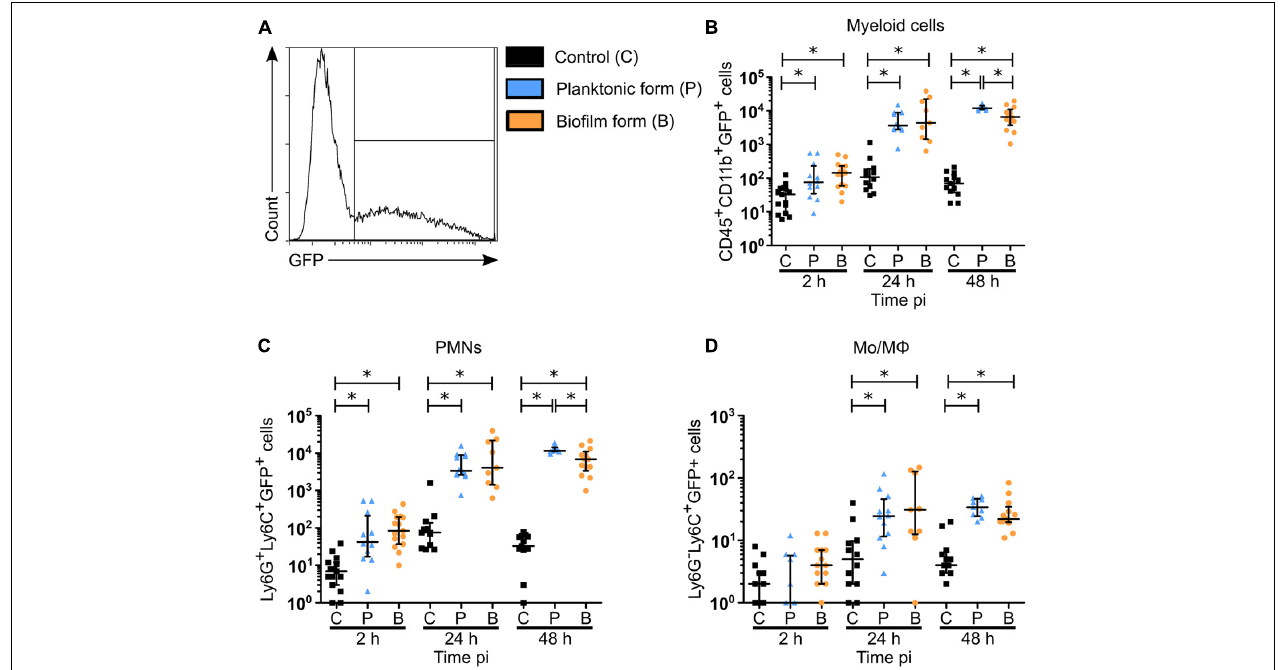
FIGURE 6 | Biofilm bacteria associated myeloid cells in the skin of S. aureus infected mice. (A) Flow cytometric analysis showing the gating strategy to analyze GFP-SH1000 associated cells among myeloid cells (CD45 + CD11b + GFP + ), PMNs (Ly6G + Ly6C + GFP + ), and MOs/M (cid:56) s (Ly6G - Ly6C hi GFP + ). Representative histogram is shown from planktonic infected WT C57BL/6J mice at 48 h pi. (B–D) Total number of bacteria associated myeloid cells (B) , PMNs (C) , and MOs/M (cid:56) s (D) in ear pinna tissue of control and planktonic or biofilm infected mice, from 2 h pi to day 2 pi (median ± IQR, number of mice: N C = 12–15, N P = 9–12, N BF = 9–15, from at least 3 different experiments, Mann-Whitney two-tailed test, ∗ p <